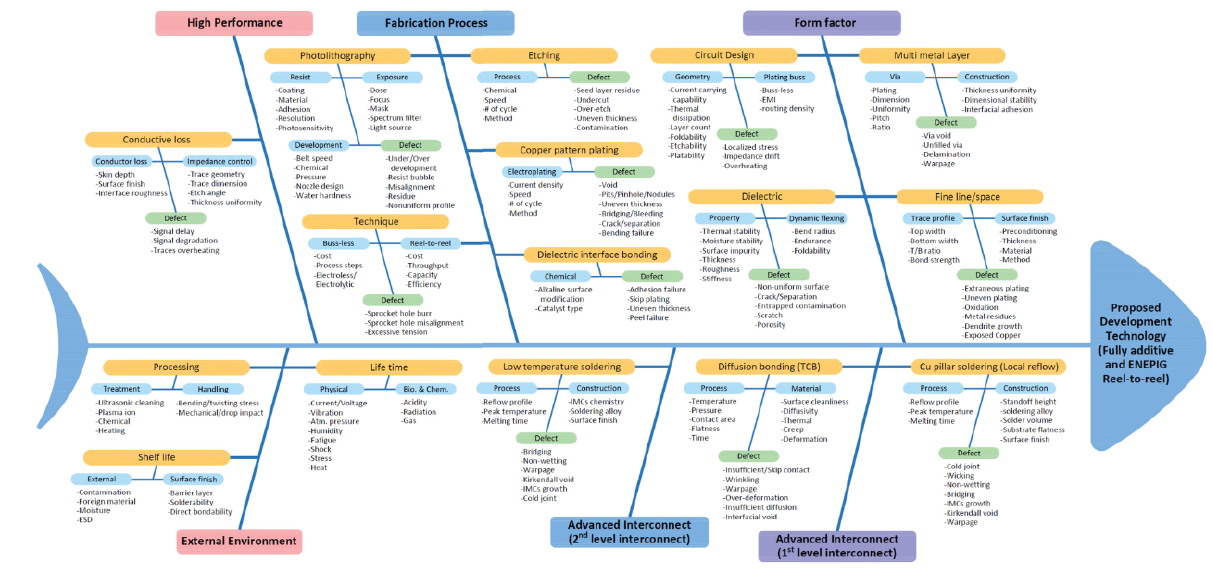
Figure 12. Factors and failure mode of the proposed technology development